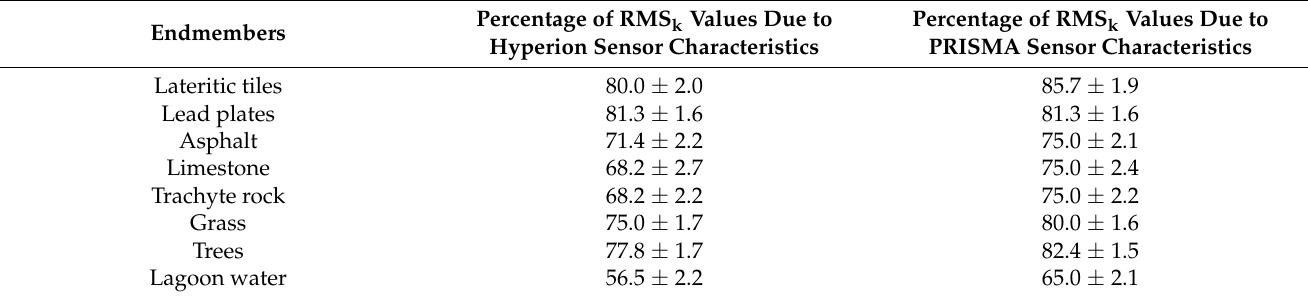
Table 4. The percentage of RMS k values due to the sensor characteristics added to the biases in the simulation of the real